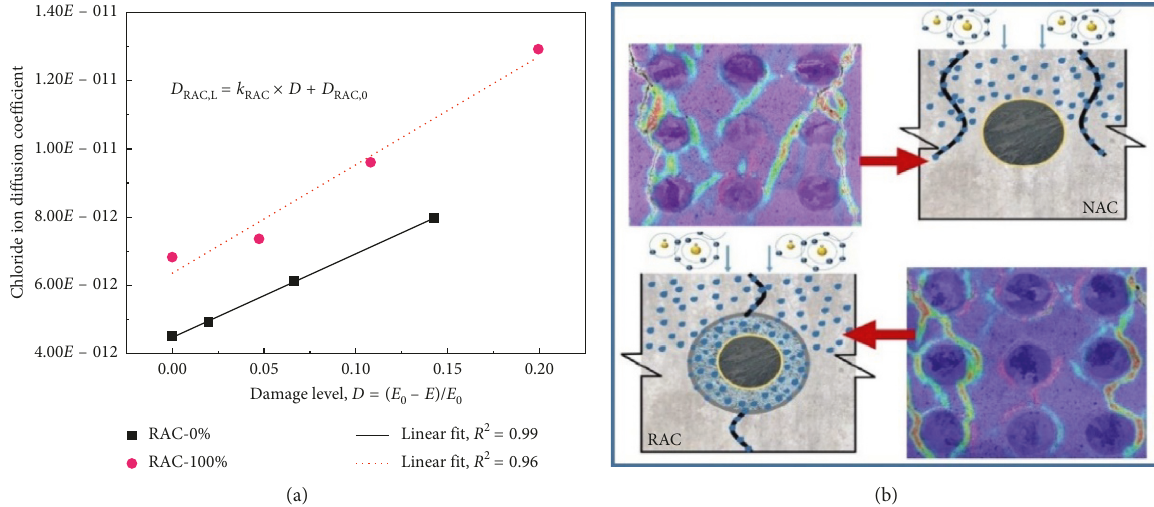
Figure 9: Relationship between the chloride diffusivity of RAC and the loading damage.